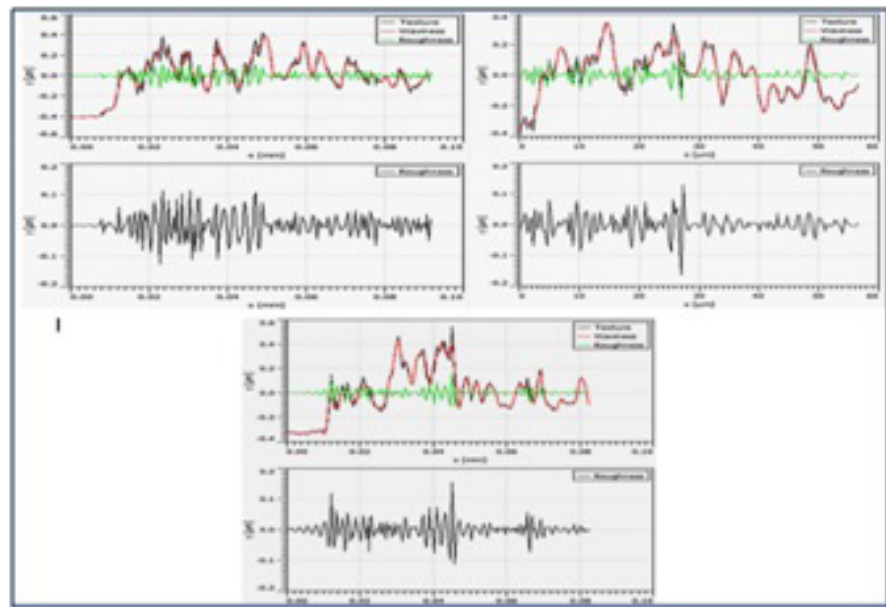
Figure 11. Surface profile graph at different cutting